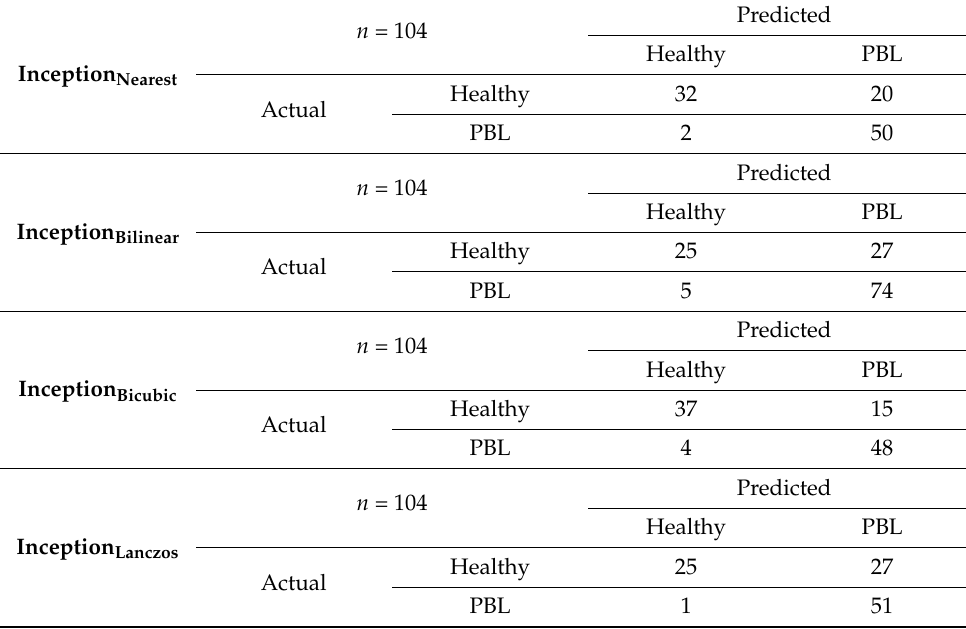
Table 5. Confusion matrix results for each Inception